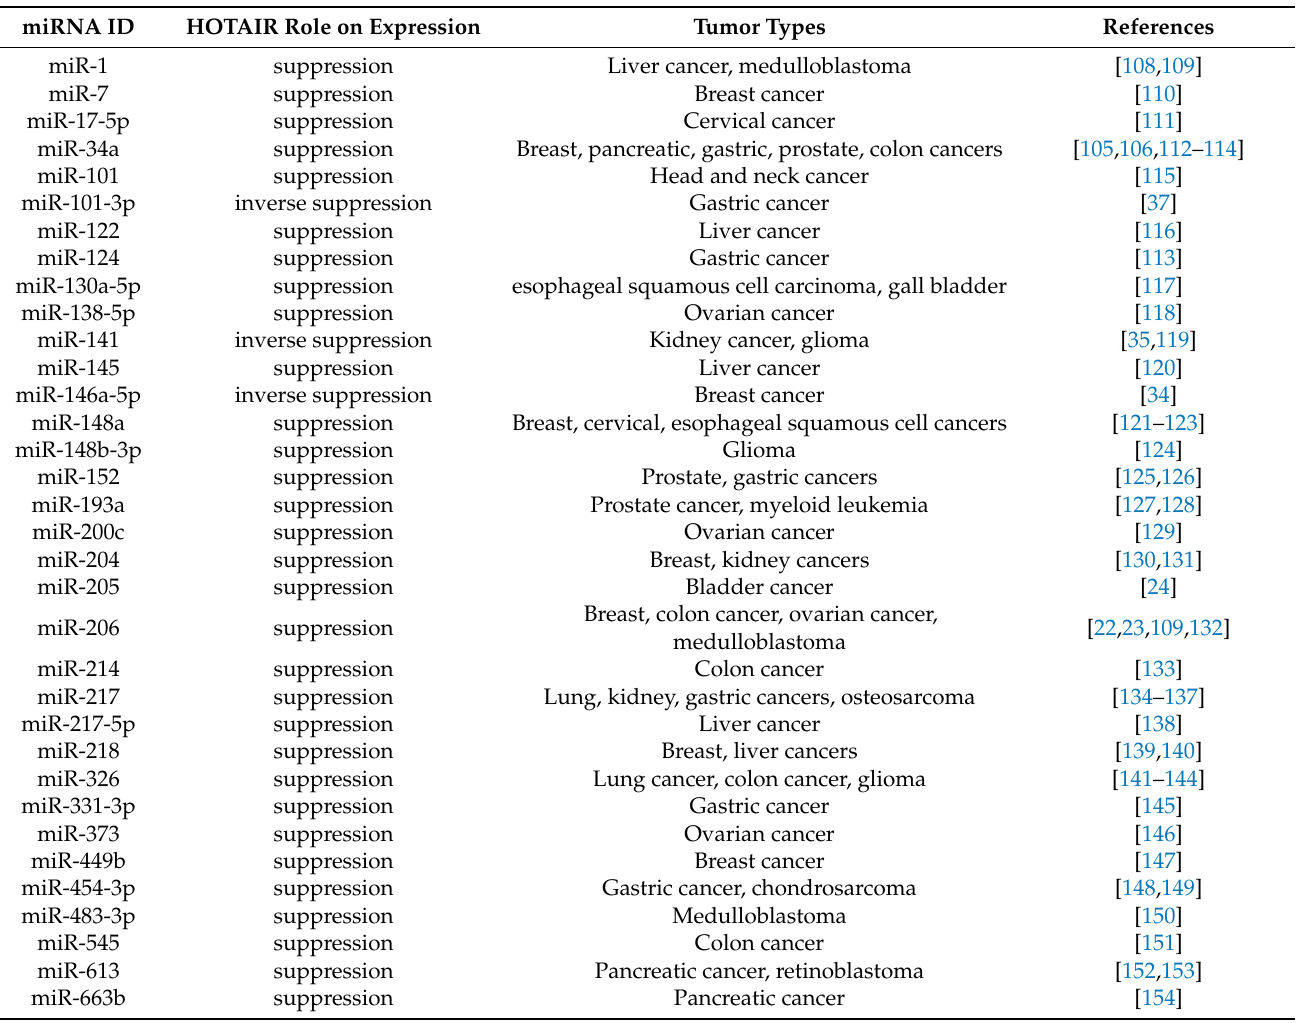
Table 1. HOTAIR miRNA targets in human